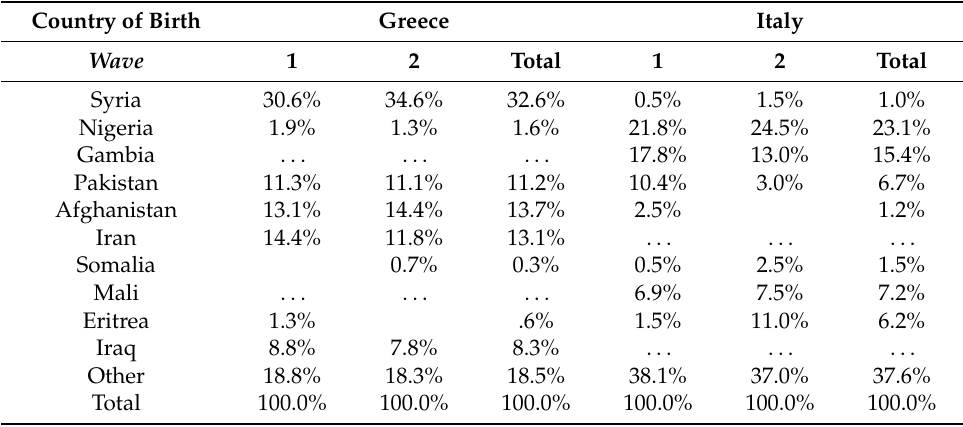
Table 1. Participants by survey country, wave and country of birth. Country of